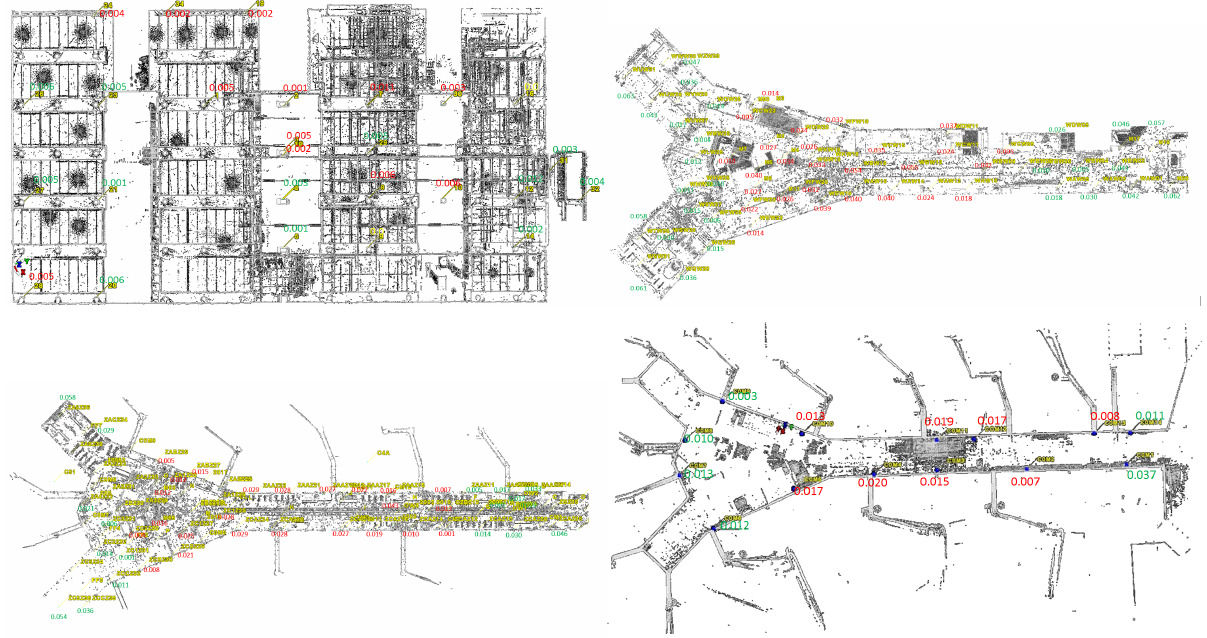
Figure 2: Overview deviations in the Z-direction per control point: PVPO (Top left), F-pier (Top right), C-pier V1 (Bottom left) and C-pier V0 (Bottom right). The values depicted in green indicate that the vertices are above the control points. The values in red indicate that the vertices are below the control points.